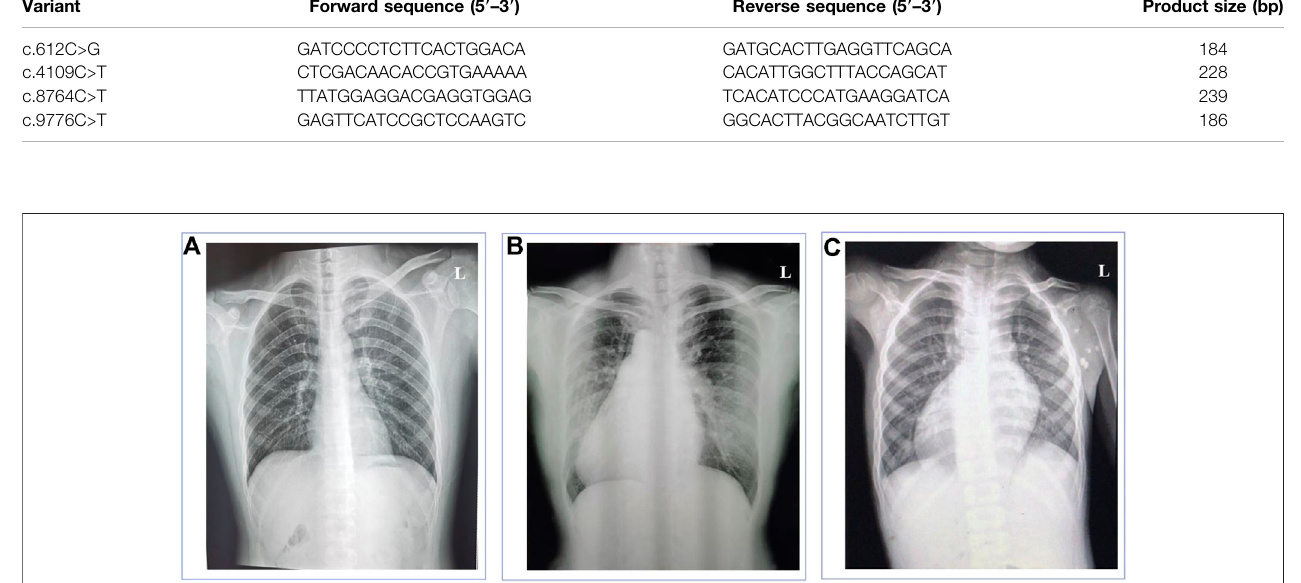
FIGURE1| ChestX-rayimagesofthenormalindividualand patients withleft-rightasymmetrydisorders. (A) Chest X-rayofthenormalindividual presented normal organ placement. (B) Chest X-ray of the proband in family 1 revealed dextrocardia. (C) Chest X-ray of the proband in family 2 revealed dextrocardia.